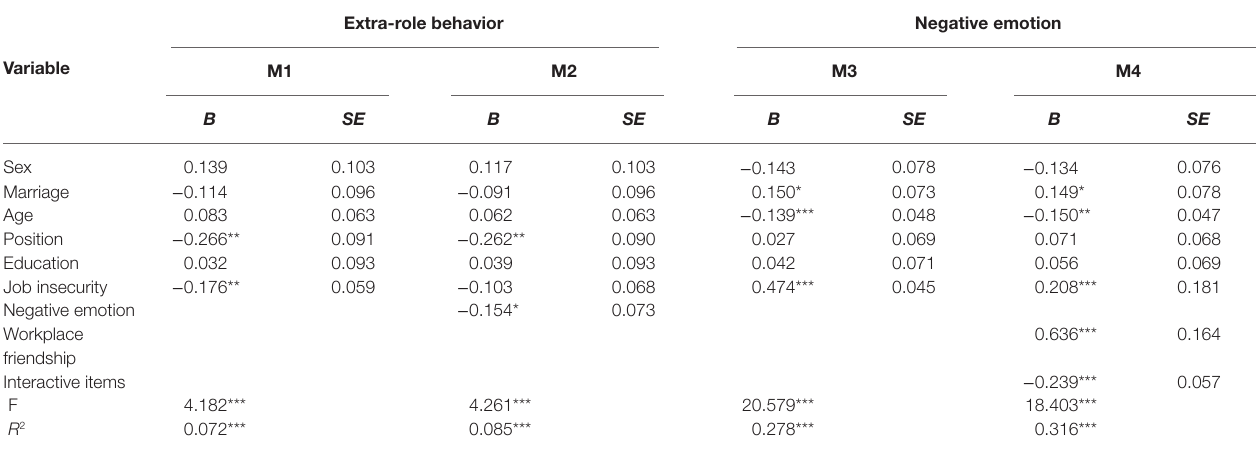
TABLE 3 | Mediating and moderating